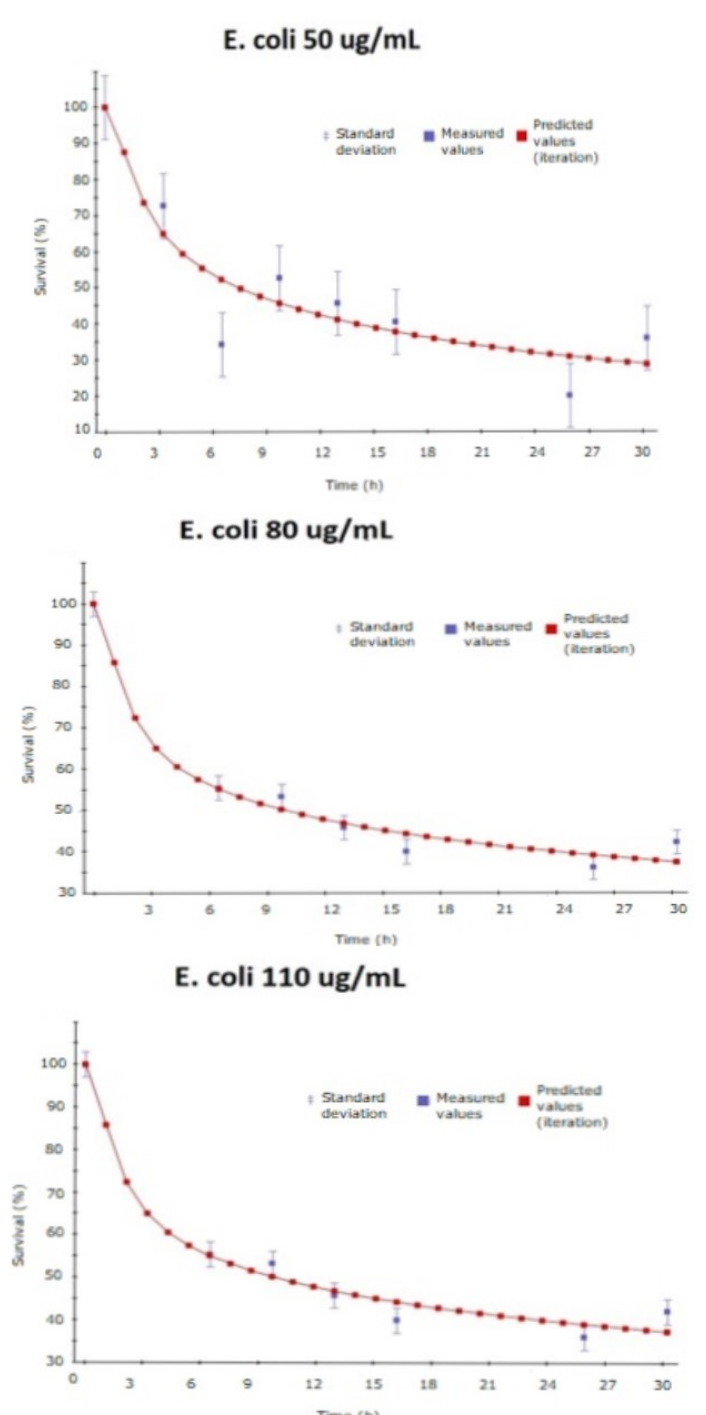
Figure 7. Experimental data and model prediction fitting for E. coli.